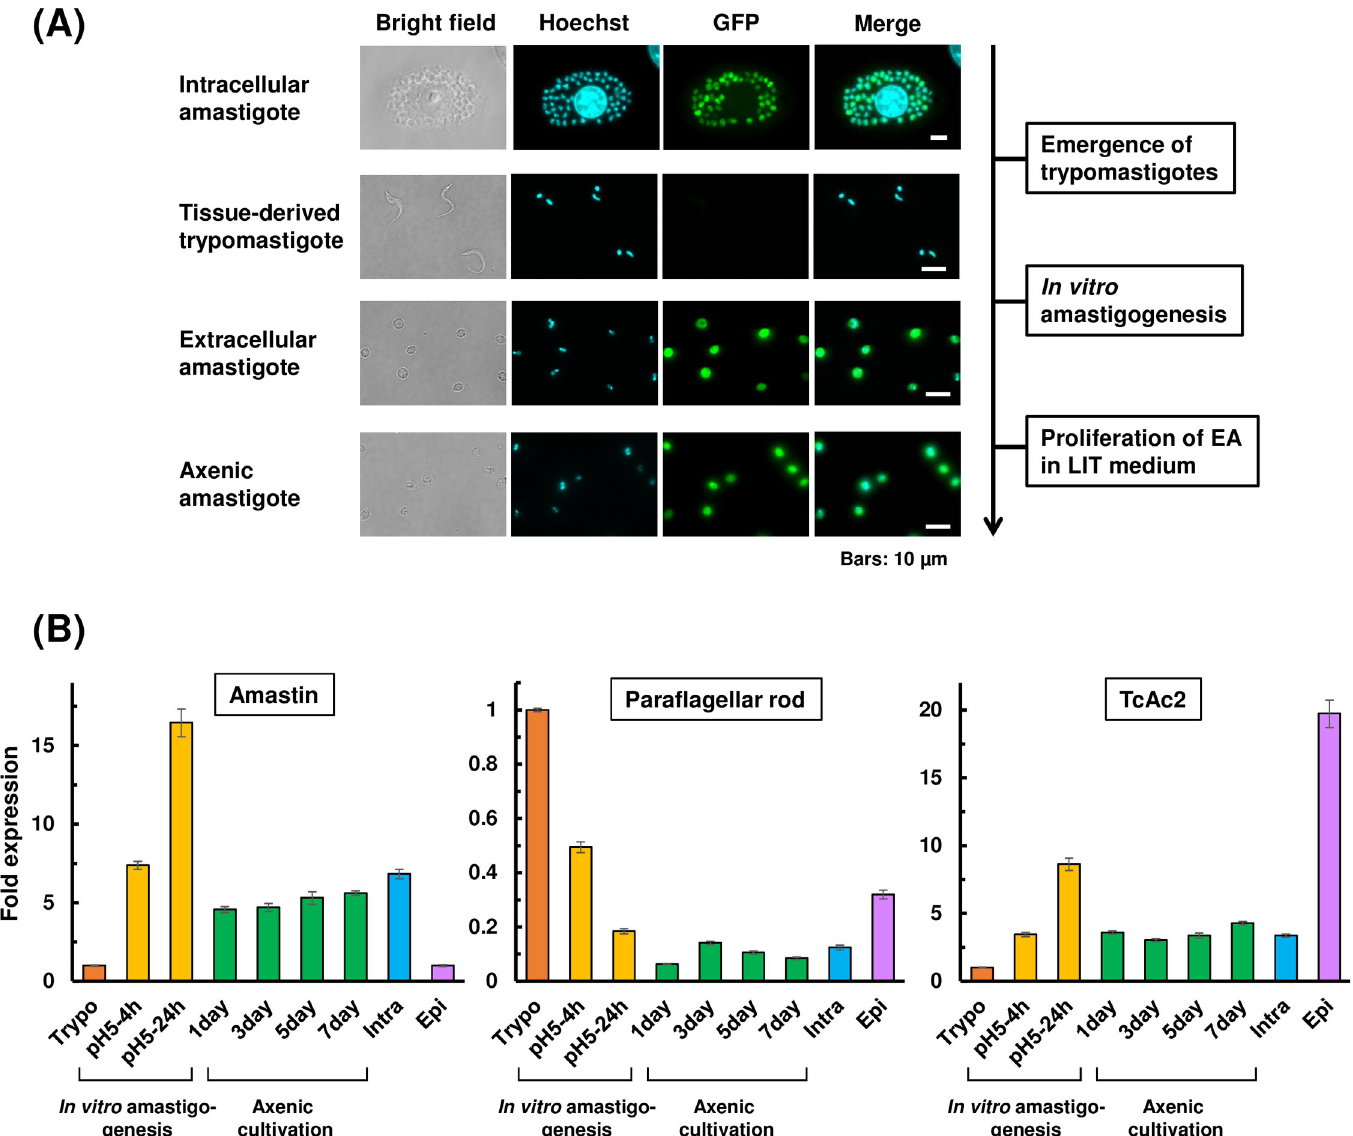
Fig 2. UTR-regulated GFP expression and differentially expressed endogenous genes in axenic amastigotes. (A) EGFP expression of EGFP-ama cell line in intracellular amastigote, tissue-derived trypomastigote, EA produced by in vitro amastigogenesis, and axenic amastigote after 5 days of LIT cultivation. Scale bars: 10 μ m. (B) Expression levels of stage-specific genes analyzed by RT-qPCR. Total RNA was extracted from trypomastigote (Trypo), transforming trypomastigote in DMEM (pH 5.0) during in vitro amastigogenesis at 4 h (pH5-4h) and at 24 h (pH5-24h), axenic amastigote maintained in LIT medium at 37˚C for indicated time period (1day, 3day, 5day, and 7day), intracellular amastigote harvested by host cell lysis (Intra), and epimastigote (Epi). Target genes, δ -amastin, paraflagellar rod protein and TcAc2, were previously shown to be upregulated in amastigote, trypomastigote and epimastigote stages, respectively[33,34]. The fold expression is normalized to Trypo. Two independent experiments were performed to ensure the reproducibility, and values from one representative experiment are plotted. The error bar represents SD of qPCR reactions performed in